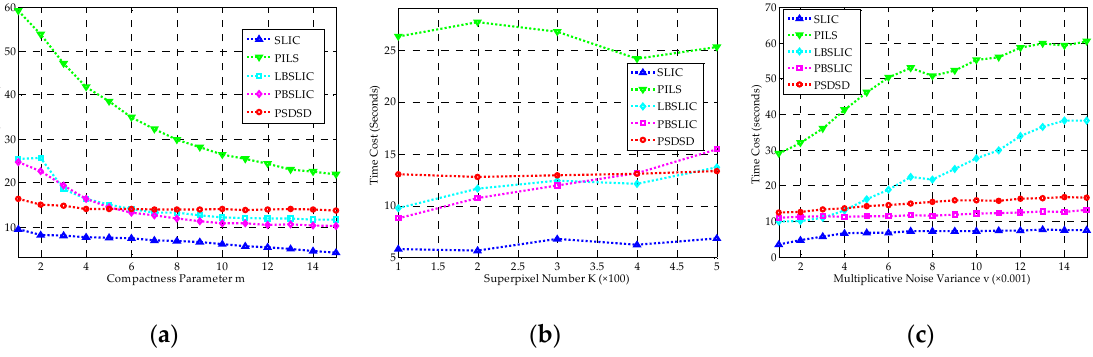
Figure 15. The Time Cost (TC) results for SLIC, PILS, LBSLIC, PBSLIC, and PSDSD. ( a ) Results with K set to 240, v set to 0.0075, and m set between one and 15; ( b ) Results with m set to eight, v set to 0.0075, and K set between 100 and 500; ( c ) Results with m set to eight, K set to 240, and v set between 0.001–0.015.